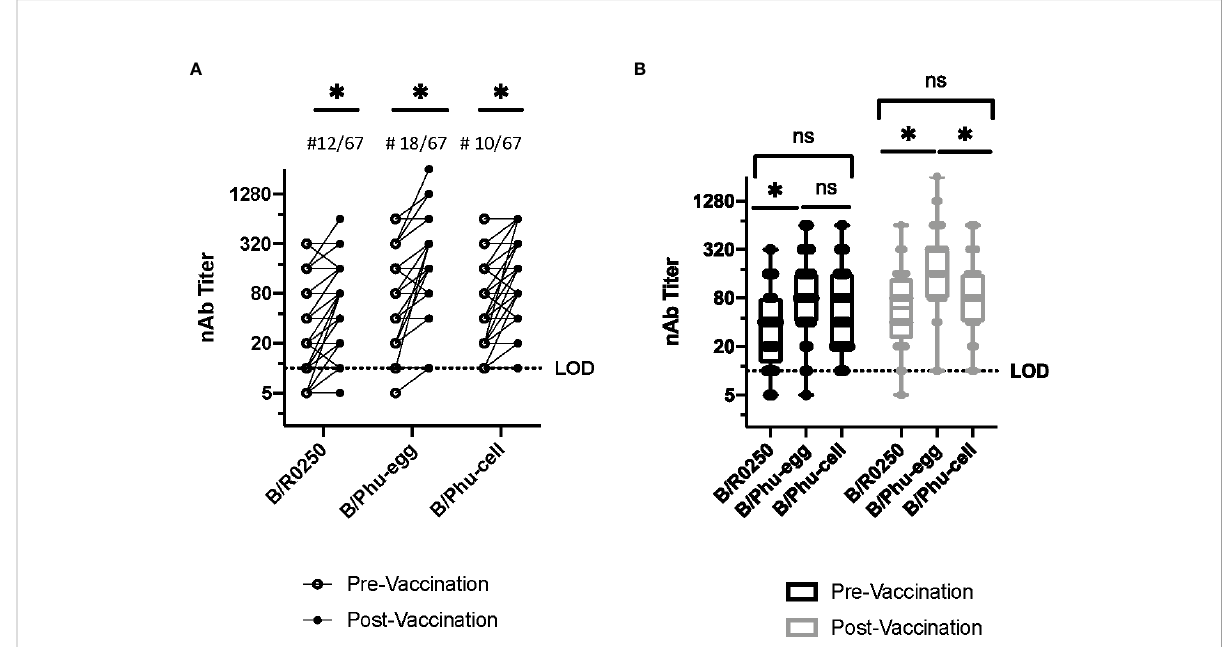
FIGURE 3 Neutralizing Antibody Assays, Vaccinated Healthcare Workers. A group of 67 healthcare workers had serum samples taken at Johns Hopkins Hospital before vaccination and 4-6 weeks after vaccination in 2019-2020. These serum samples were used to compare the viruses compared above, B/R0250, B/Phu-egg and B/Phu-cell. (A) Comparison of neutralizing antibody titers using the pre-vaccination and post-vaccination serum of patients vaccinated with the quadrivalent IIV. B/Baltimore/R0250/2018 (B/R0250), B/Phuket/3073/2013-egg cultured (B/Phu-egg) and B/Phuket/ 3073/2013-cell cultured (B/Phu-cell) were used for comparison against patient sera. (A) Matched values pre and post vaccination. Paired T-test used to calculate signi fi cance (B) Box and Whisker plot comparing median nAb titers pre and post vaccination. Two-way Anova with multiple comparisons was used to calculate statistical signi fi cance of median value. An * indicates p<0.05 and ns indicates a not signi fi cant